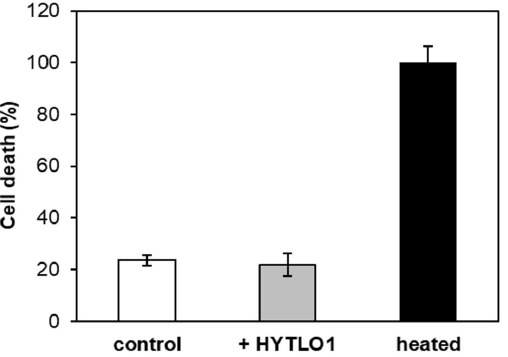
Figure 3. Effect of HYTLO1 on L. japonicus cell viability. Cell suspension cultures were treated with 0.6 µM HYTLO1 (grey bar) for 24 h. Cells incubated with the same percentage of ethanol (white bar) were used as control. 100% cell death corresponds to cells incubated for 20 min at 100 °C (black bar). Cell viability was determined by the Evans blue method. Data are the means ± SE of three independent experiments.